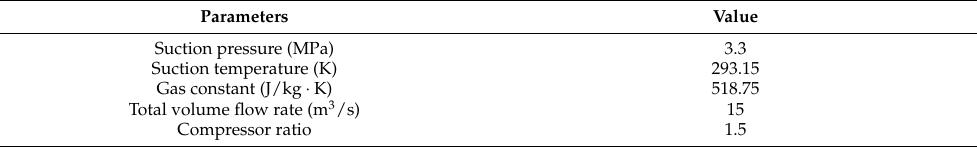
Table 4. The main parameters of the simulated operation of the booster compressor station.